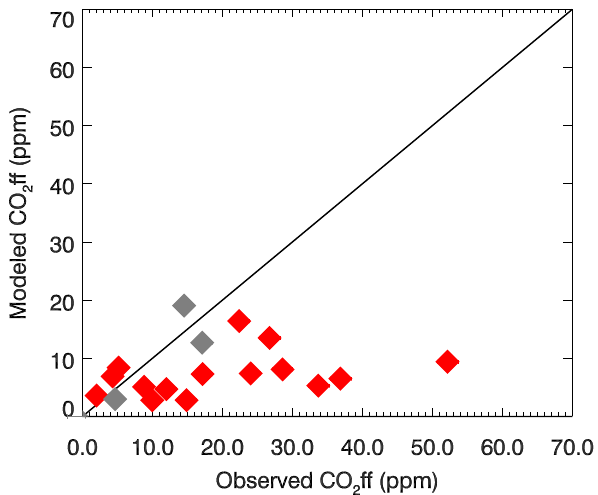
Figure 7. Observed CO 2 ff versus modeled CO 2 ff for the kite (red) and surface (grey) flask samples. Error bars are omitted for clarity.